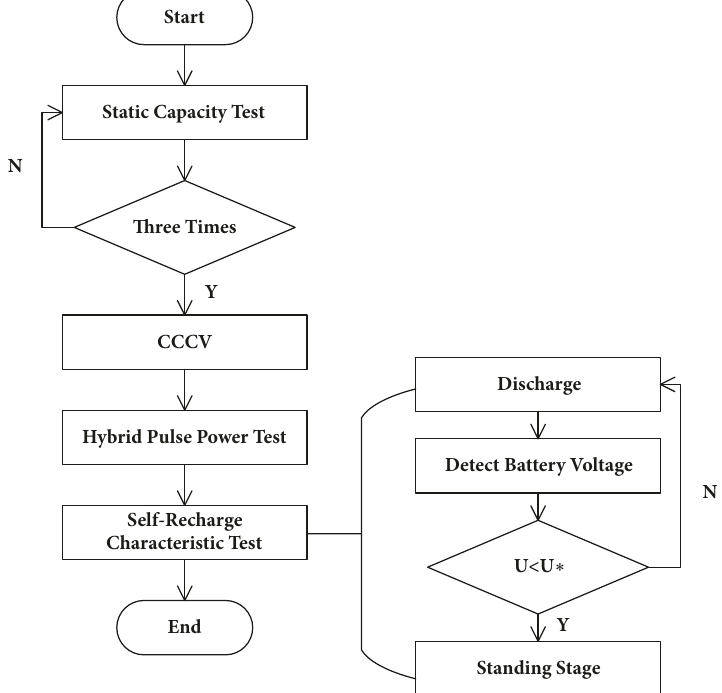
Figure 7: Experiment schedule.